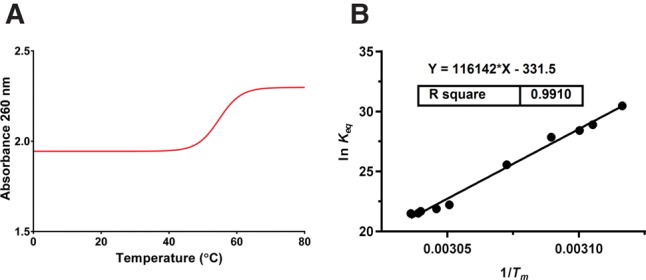
(A) Nonlinear melt curve fit (R2 > 0.99) for the WT phi29 3WJ construct collected at 31.2 µM showing a sharp, cooperative transition. Data points were collected at a rate of 6/s with a heating rate of 1°C/min. (B) van't Hoff plot of phi29 3WJ melt data (R2 > 0.99), where the slope is −ΔH/R and the y-intercept is ΔS/R. Data were fit using the Marquardt–Levenberg method in Meltwin (McDowell and Turner 1996).